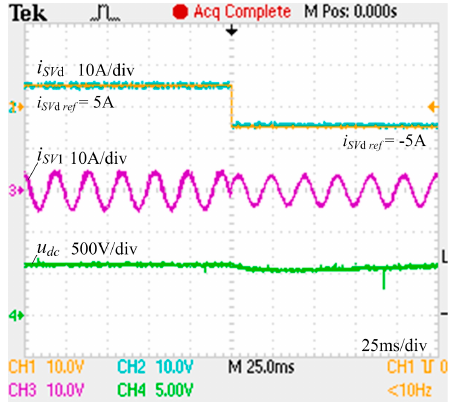
Figure 12. DC-bus voltage and phase current experimental result. CH1: i SVdref , 10 A/div; CH2: i SVd , 10 A/div; CH3: i SV 1 , 10 A/div; CH4: u dc ; 500 V/div; 25 ms/div.